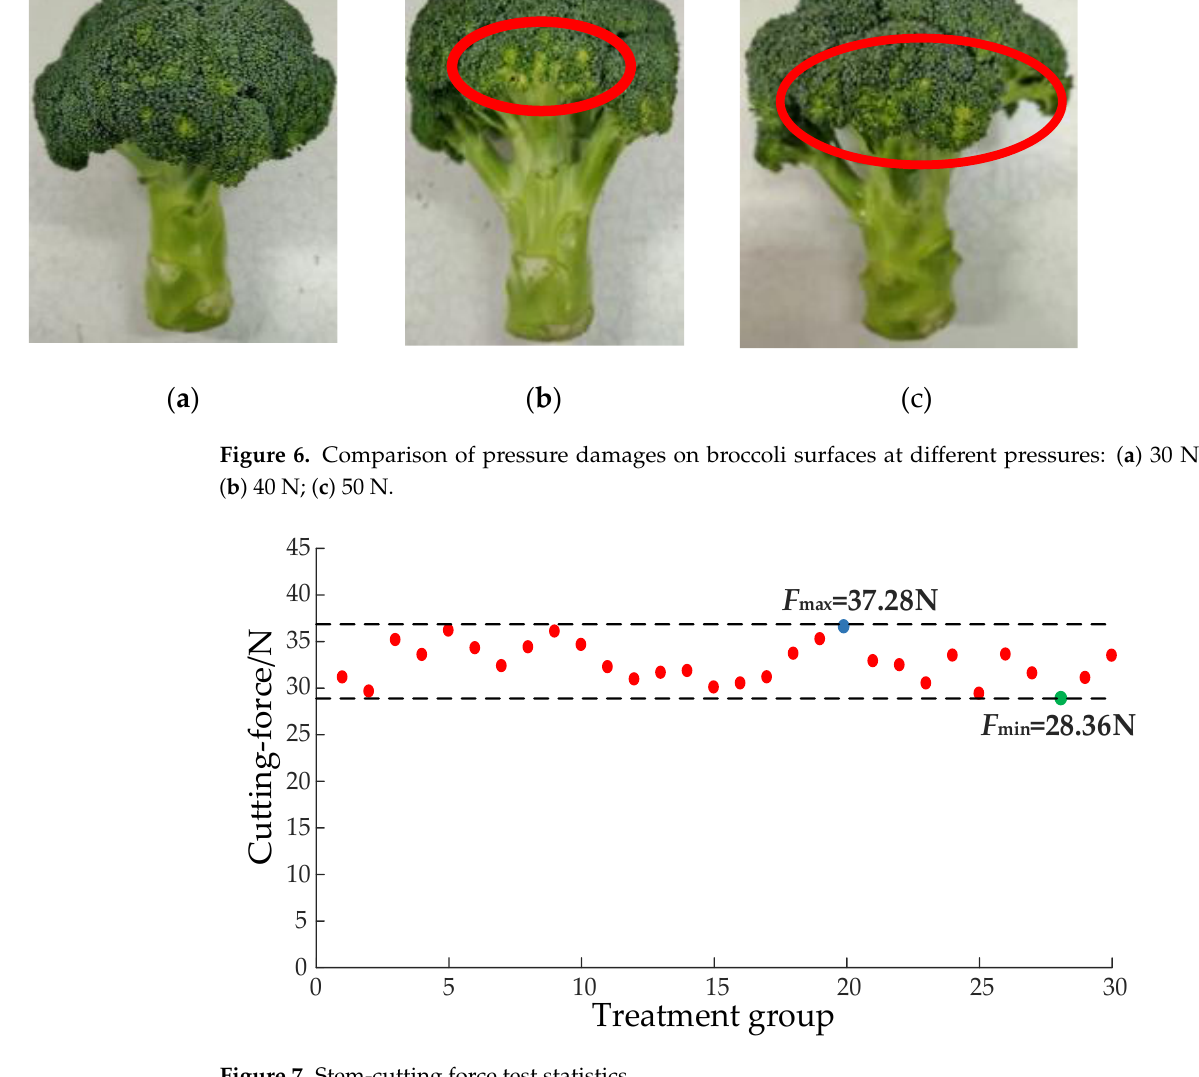
Figure 7. Stem-cutting force test statistics.